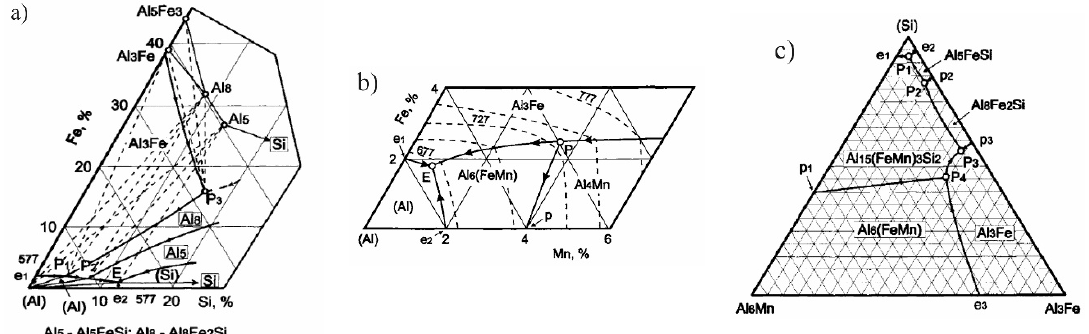
Figure 1. Phase diagram of an Al-Fe-Si system ( a ), a liquidus projection of an Al-Fe-Mn system ( b ), and a polythermal projection of the solidification surface of an Al-Fe-Mn-Si system ( c ) reproduces from reference [12].